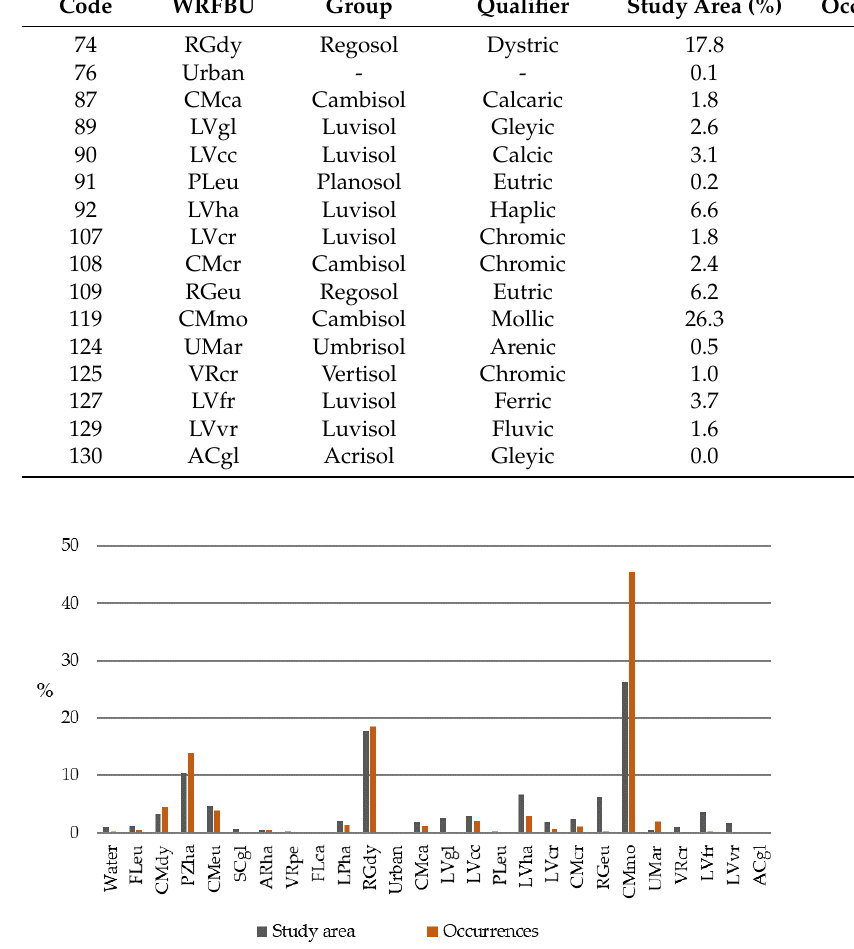
Figure 3. Soil codes ( WRBFU ) in the study area and in Maritime pine occurrences. Table 2. Soil codes (WRBFU) according to the international classification system.